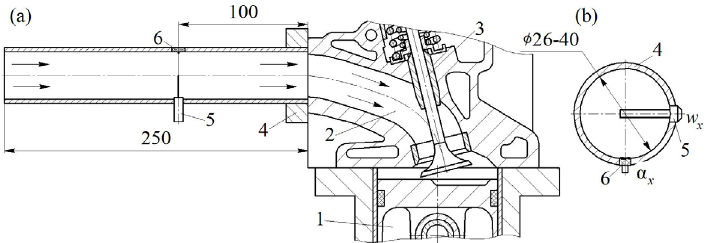
Figure 2. Diagram of the intake system ( a ) and cross section of the control section ( b ) (arrows indicate the air flow direction): 1—piston; 2—supply channel; 3—head of the engine pack; 4—inlet pipe;